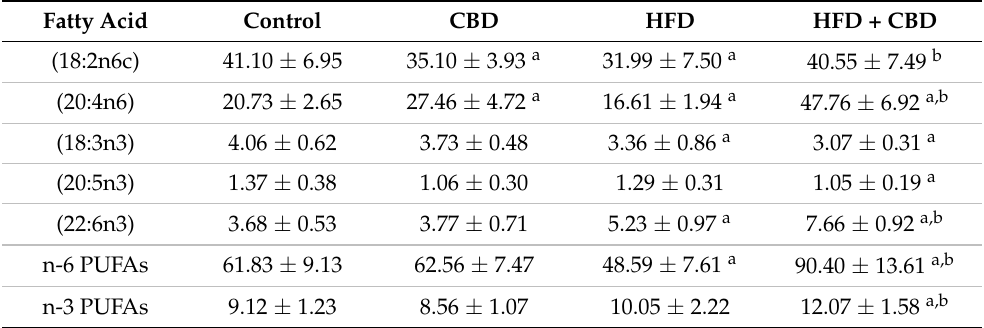
Table 3. Polyunsaturated fatty acids (PUFA) content in the DAG fraction (nmol/g of wet tissue) in the white gastrocnemius muscle in the control (standard diet) and high-fat diet (HFD) groups after two-week cannabidiol (CBD) treatment.